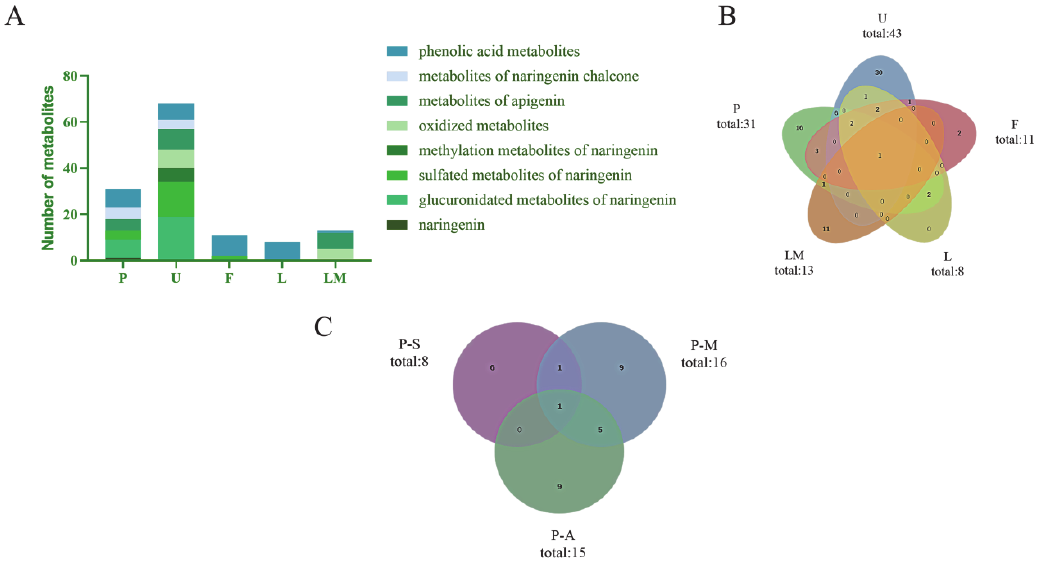
Figure 6. Distribution of naringenin metabolites in samples. ( A ): classification and distribution of metabolites in different metabolic samples (P: plasma; U: urine; F: feces; L: liver tissue; LM: liver microsomes); ( B ): quantity distribution of metabolites in different metabolic samples (P: plasma; U: urine; F: faces; L: liver tissue; LM: liver microsomes); ( C ): distribution of naringenin metabolites in samples with different preparation methods (P ‐ S: plasma—SPF solid phase extraction method;